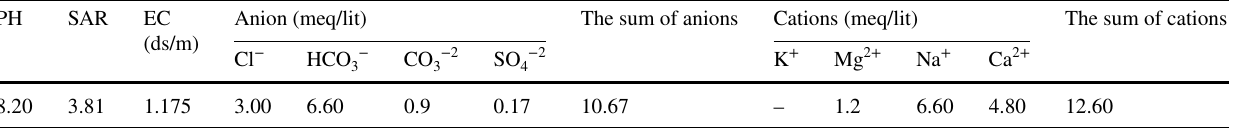
Table 3 Chemical analysis of the well's water sample from the Doshan Tappeh research site PH SAR EC Anion (meq/lit) The sum of (ds/m)